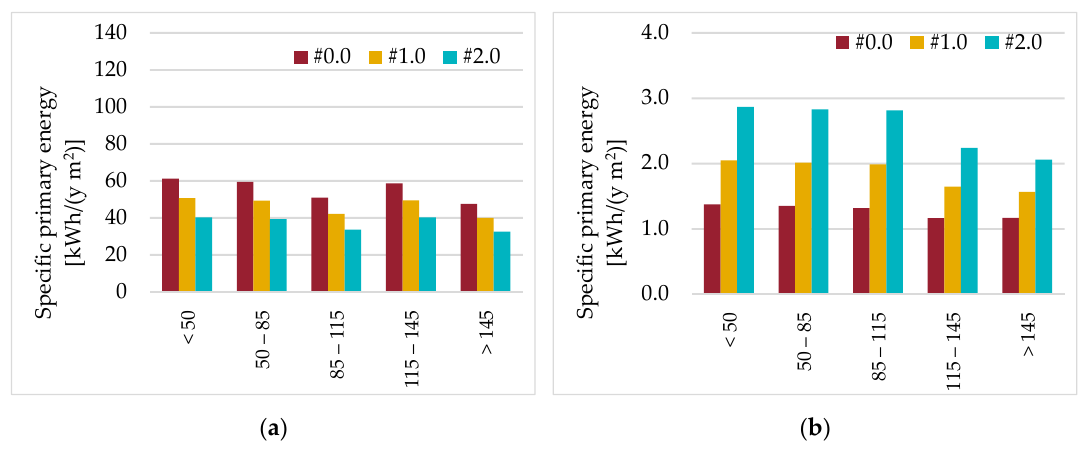
Figure 12. Rome: Specific primary energy consumption. ( a ) Heating; ( b ) cooling.